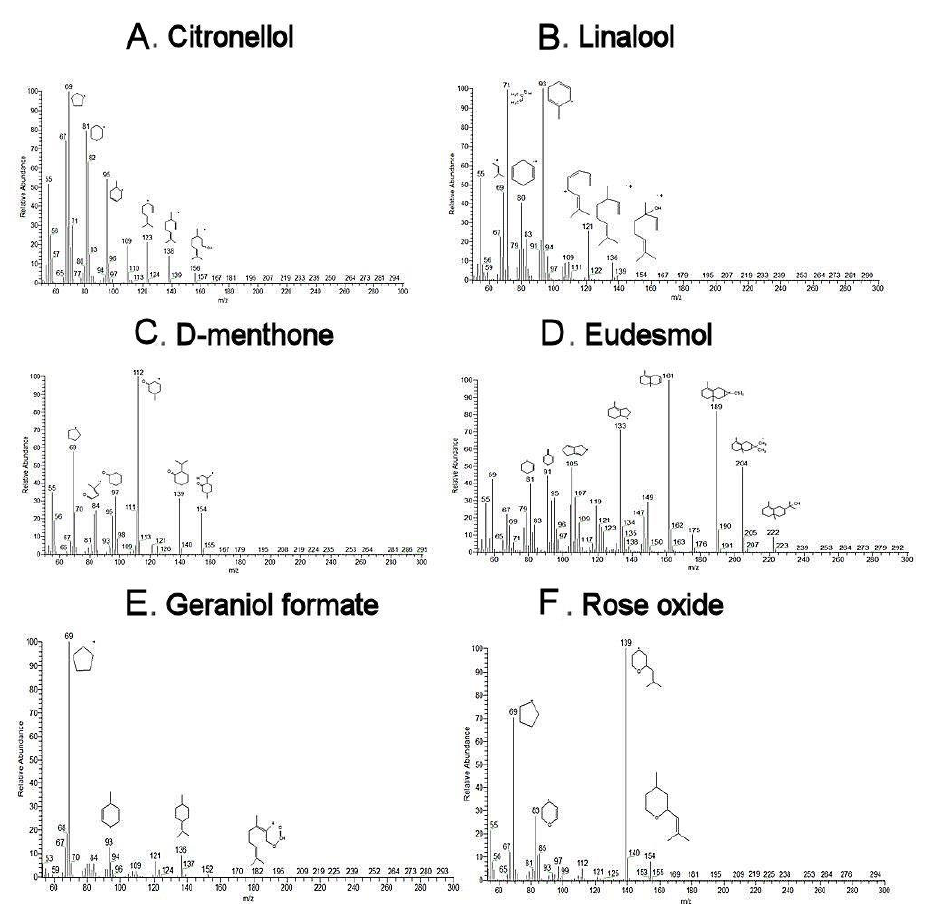
Figure 2. EI Mass Spectra of the studied components of P. graveolens : ( A ) citronellol, ( B ) linalool, ( C ) cis-Menthone, ( D ) eudesmol, ( E ) geraniol formate, and ( F ) rose